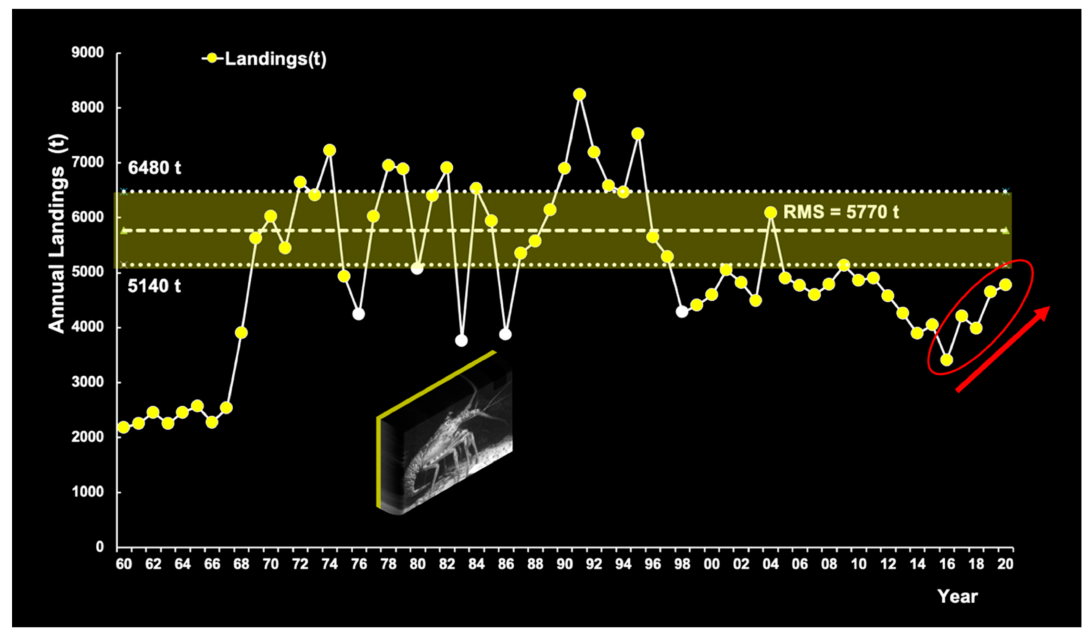
Figure 9. Fluctuations in annual landings of Brazilian form of Panulirus argus (Latreille, 1804), showing periods of overfishing (white dots) and reductions. Dotted horizontal line represents maximum sustainable yield (MSY = rk/4). Shaded area is 95% confidence interval (5140–6480 t). Oval circle and red line show an increase in landings since 2016. Adapted from Cruz et al.